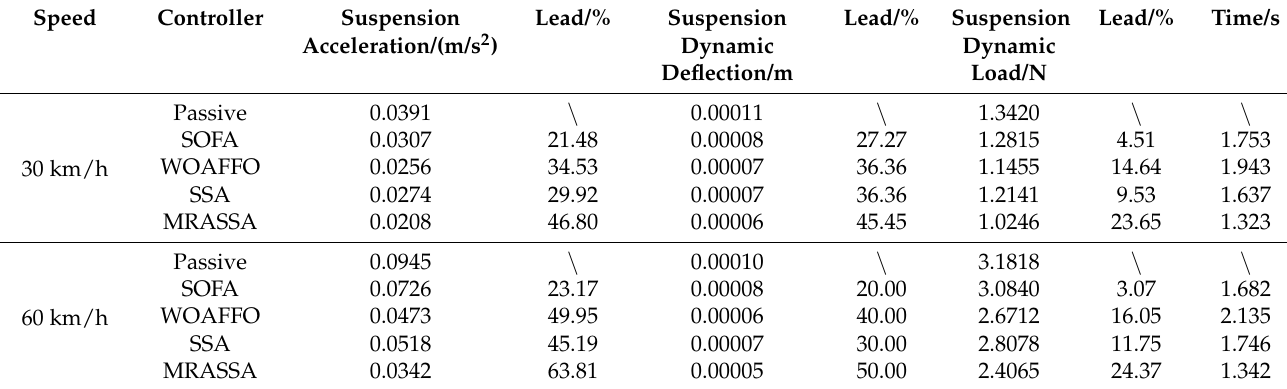
Table 3. Optimization Results for Simulation of the Single Bump.